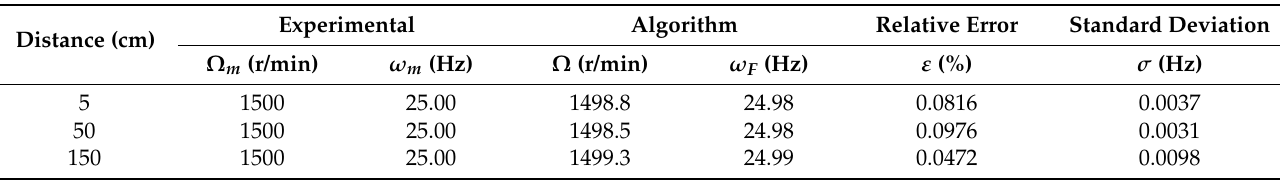
Table 14. No load coupled to the motor shaft: estimated speeds and frequencies, relative errors, and standard deviation for each test.